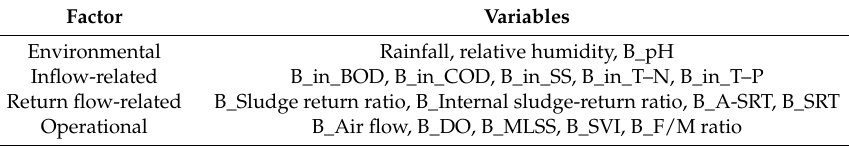
Table 5. Latent variables deduced by factor analysis for effluent T–N concentration.